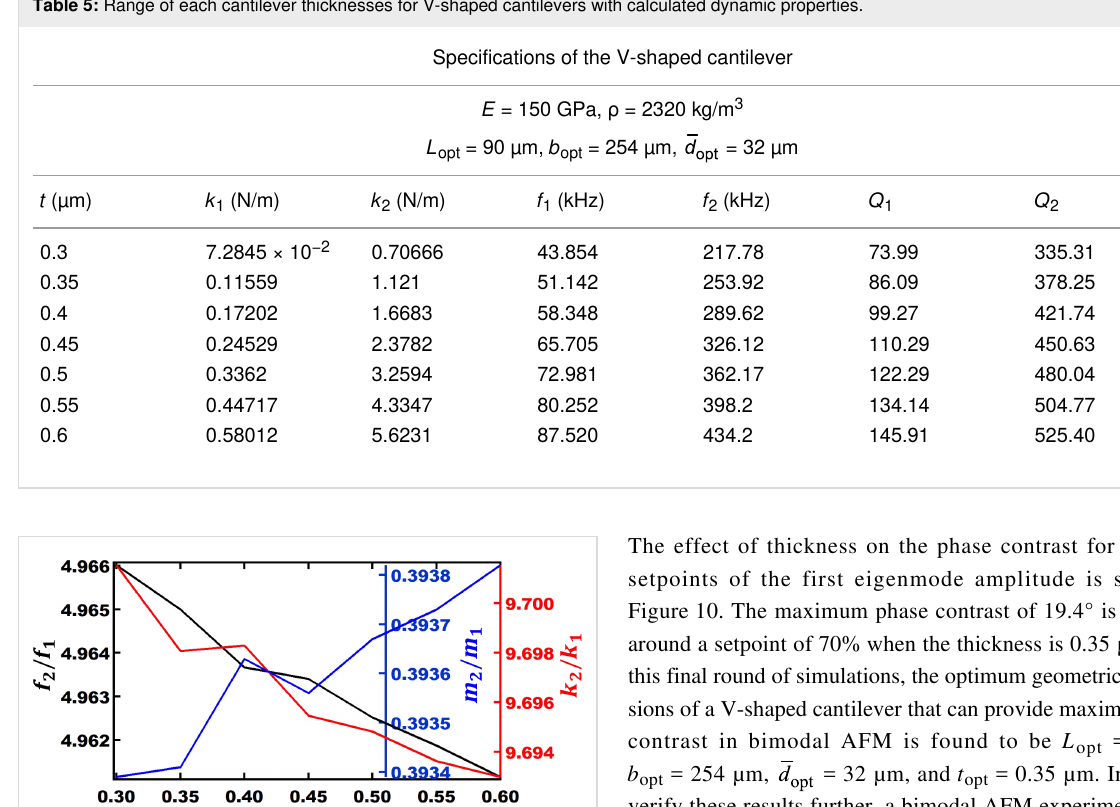
Table 5: Range of each cantilever thicknesses for V-shaped cantilevers with calculated dynamic properties.